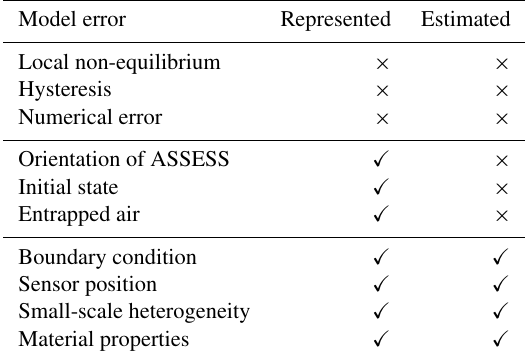
Table 3. This overview includes specification whether the consid- ered model error is represented and explicitly estimated within the scope of this